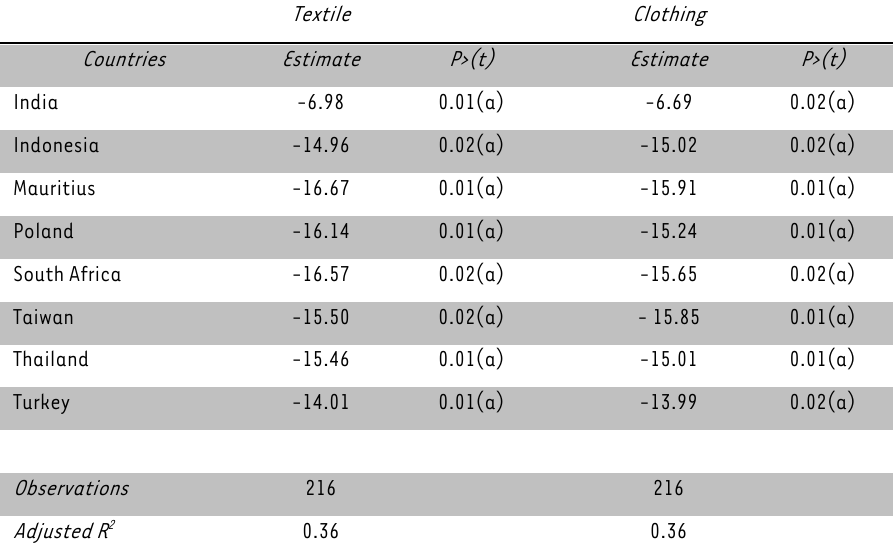
TABLE 5: Fixed-effect panel data export share estimates (China as the benchmark) Textile Clothing Countries Estimate P>(t) Estimate